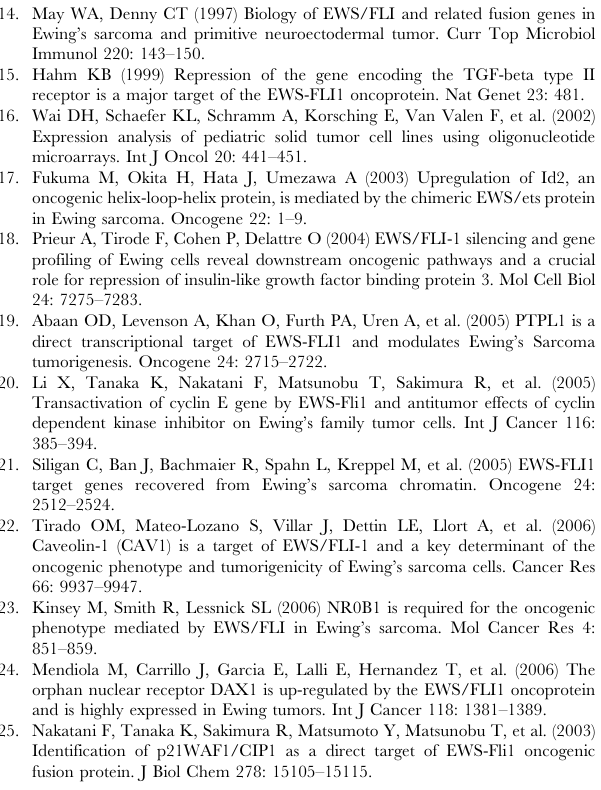
Table S3 Oligonucleotides used for microsatellite